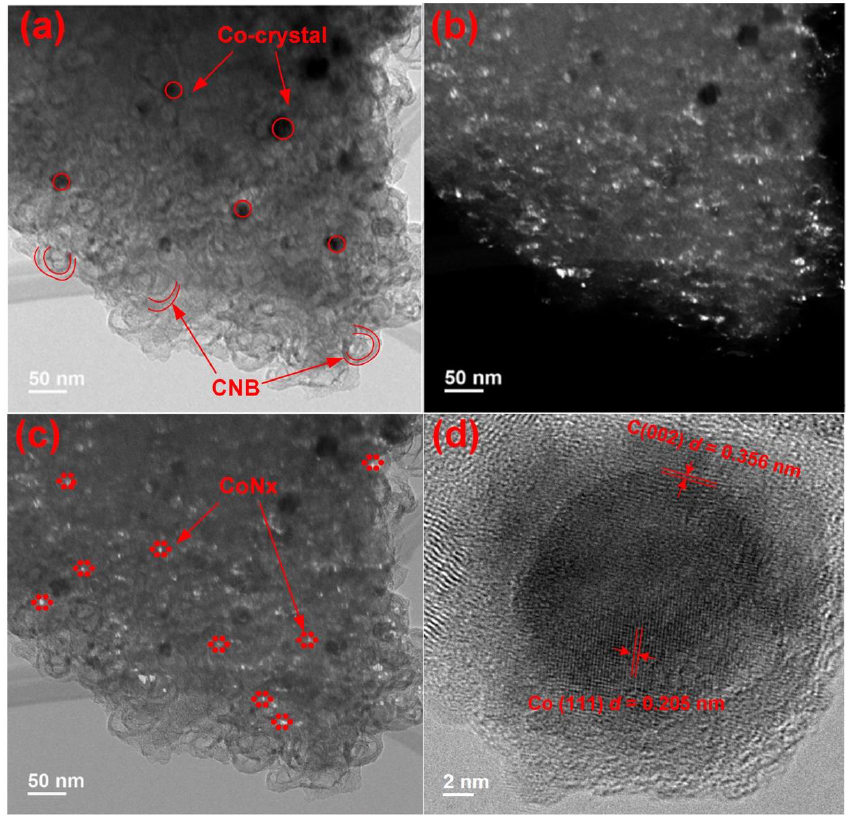
Figure 3. HR-TEM micropictures of CoNC-900A800 ( a ) bright field ( b ) dark field ( c ) overlapping of bright and dark fields ( d ) higher resolution picture for Co crystal.